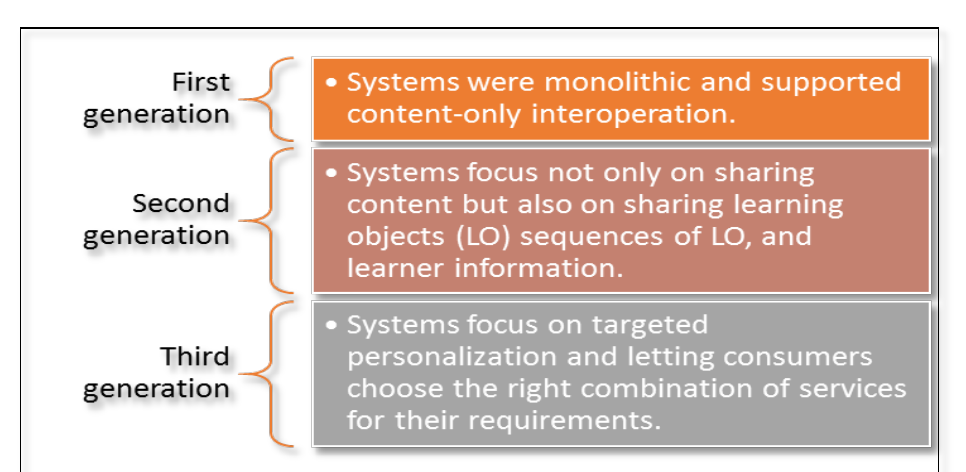
Figure 1. The three LMS generations